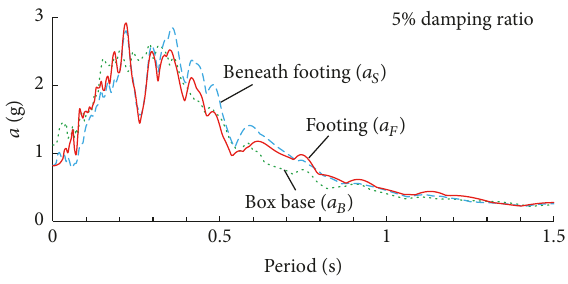
Figure 8: Response spectrum of accelerations at different locations.